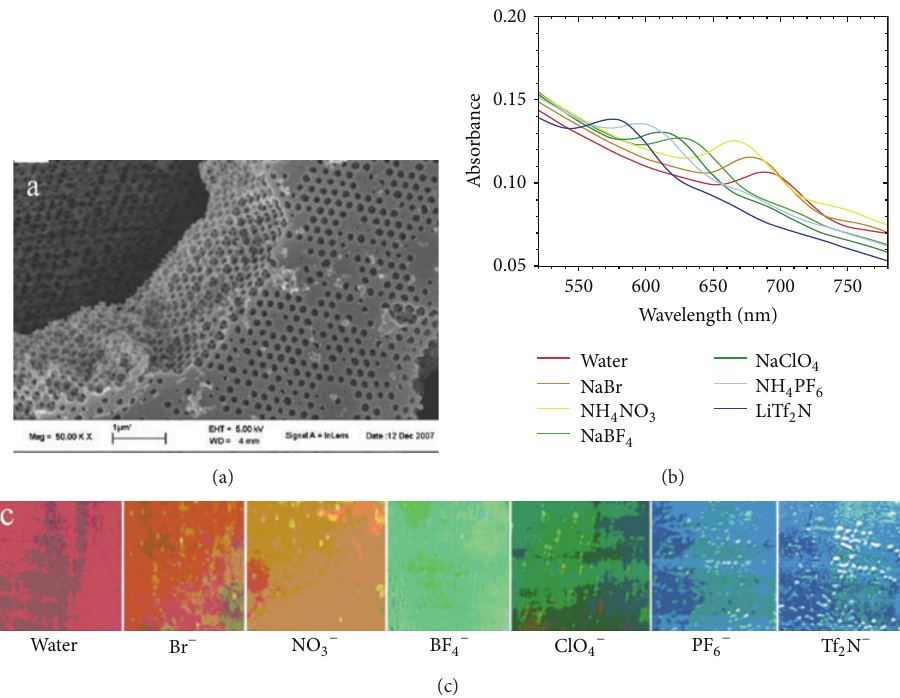
Figure 16: SEM image of the inverseopal photonic ionic liquid film (a). Stop-band shifts of the film upon soaking in various aqueous anionic solutions (b). Color changes of the film after anions aqueous solutions treatment (c) [63].